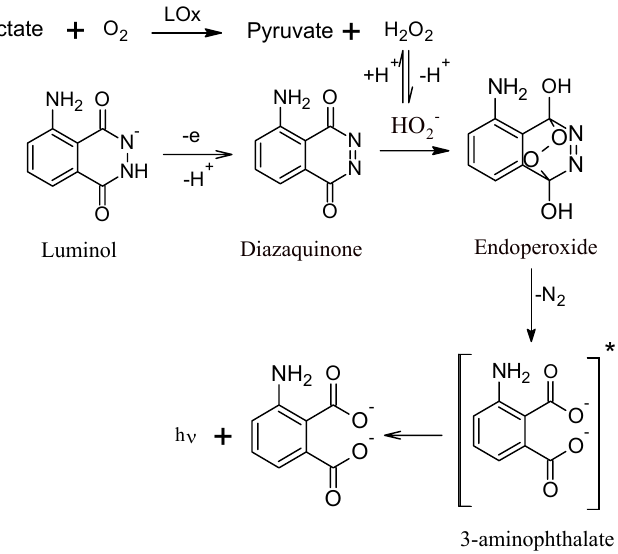
Figure 4. ECL emission mechanism of luminol when lactate and the enzyme (LOx) are in the screen-printed